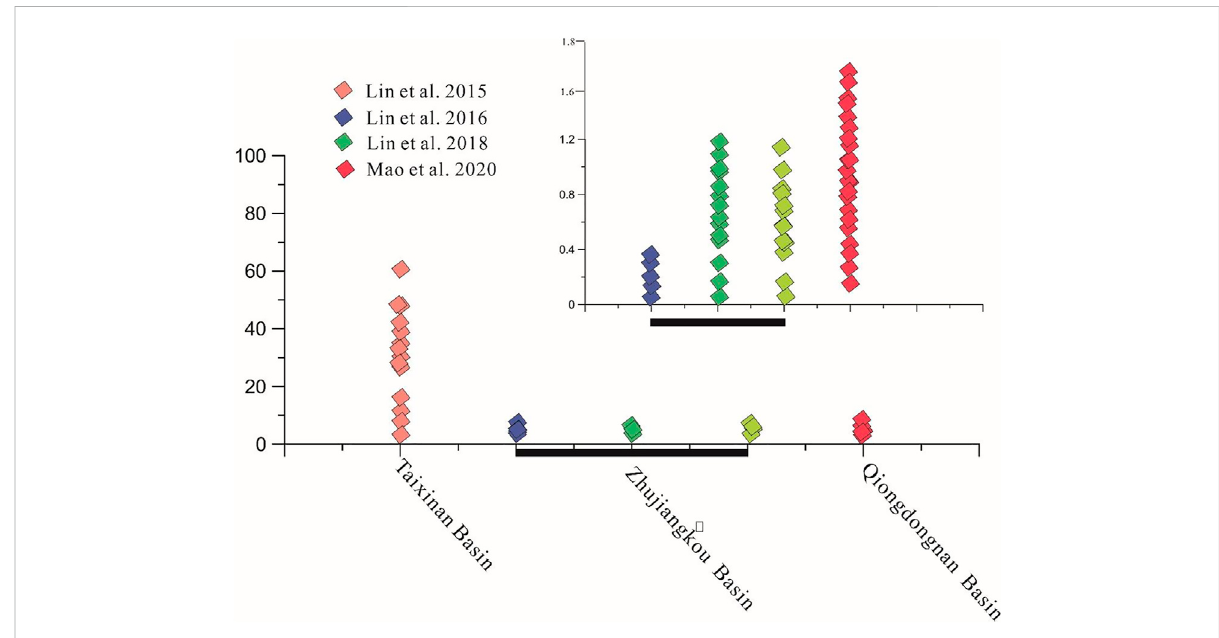
FIGURE 4 Content of pyrite at sulfate and methane transition zone in different sediments